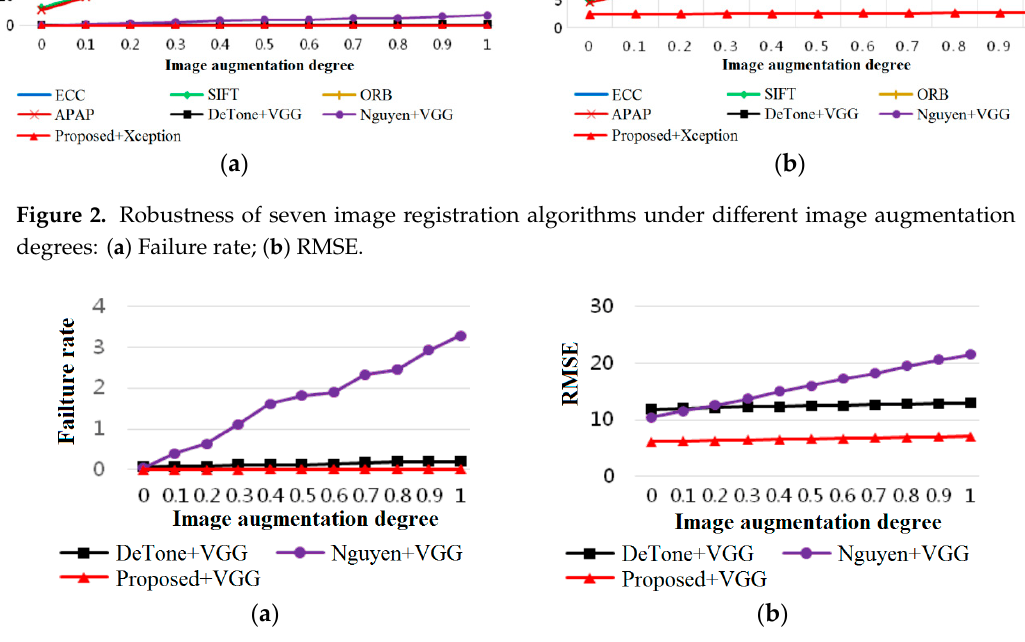
Figure 4. Robustness of DeTone’s algorithm, Nguyen’s algorithm and the proposed algorithm using Googlenet: ( a ) Failure rate; ( b ) RMSE.